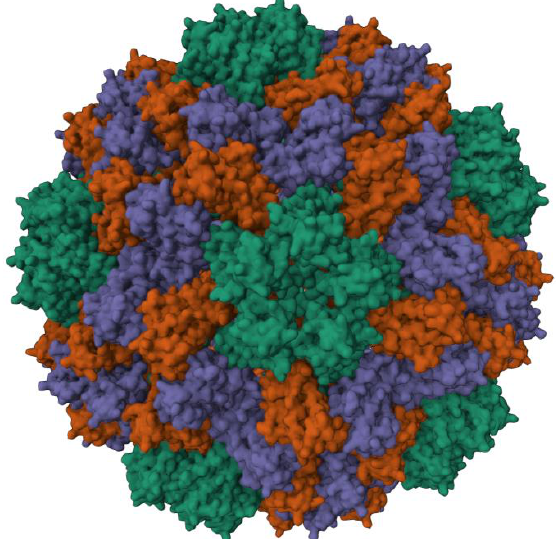
Figure 1. 3D model of the capsid of CCMV (PDB ID: 1ZA7) generated with X-ray crystallography data from the RCSB protein data bank [31] , created with Mol* Viewer [22] . The 180 subunits of the virus consist of chemically identical proteins with three types of different symmetries, highlighted in green, red, and purple, respectively. Please note that the model is created using high-resolution X-ray crystallography data of a K42R CCMV mutant.